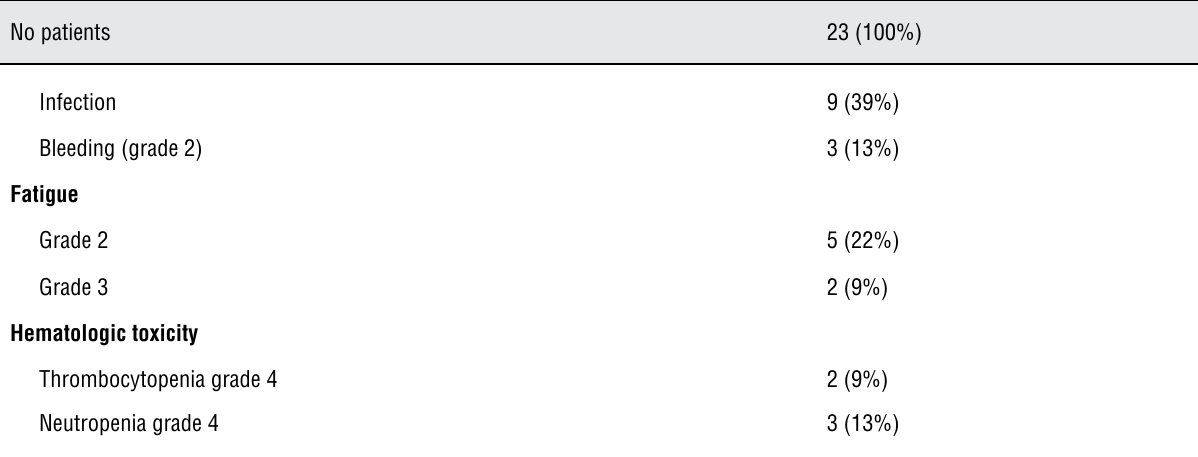
Table 3 – Toxicity